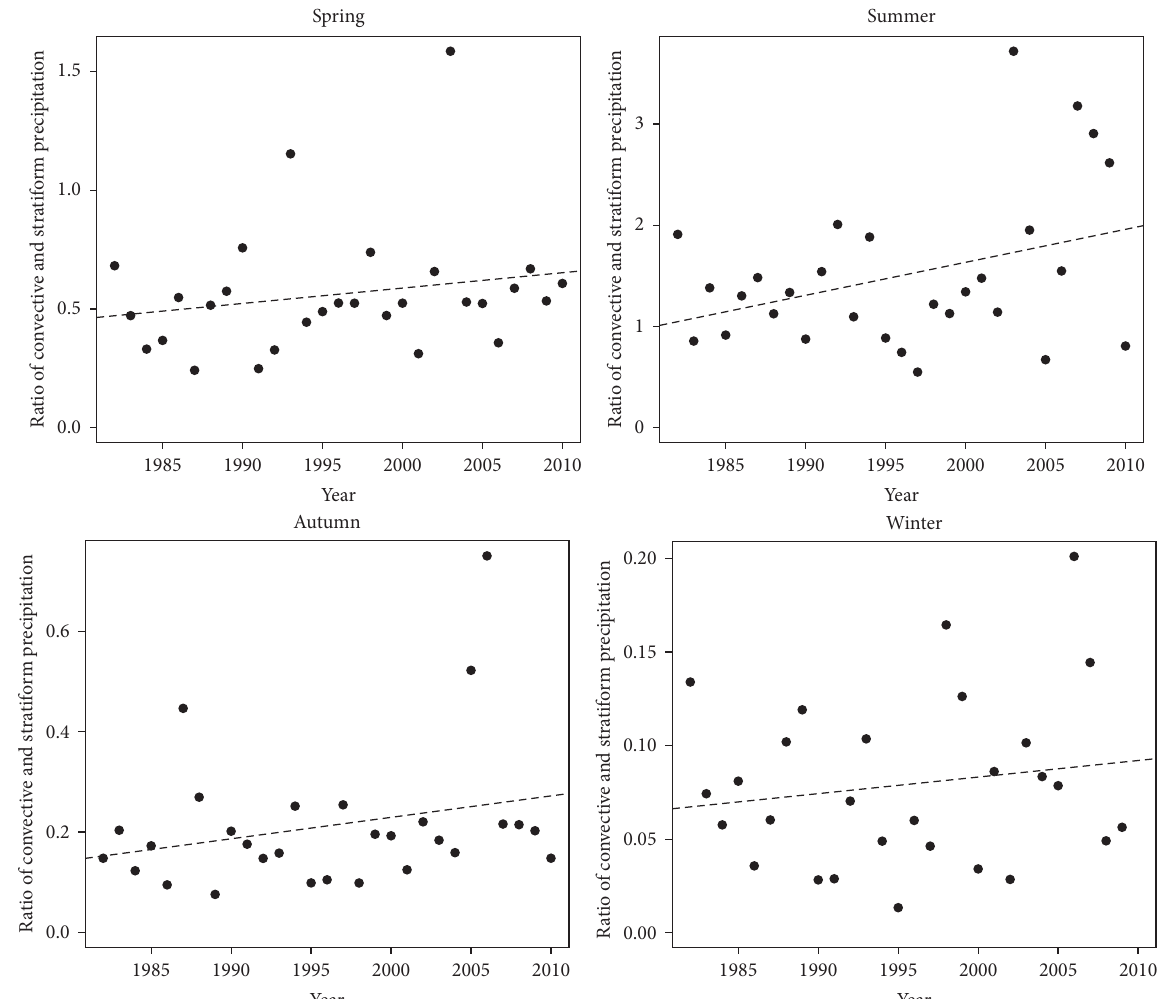
Figure 6: Ratio of convective and stratiform precipitation (averages over 11 stations in the Czech Republic) and trend estimated by the linear